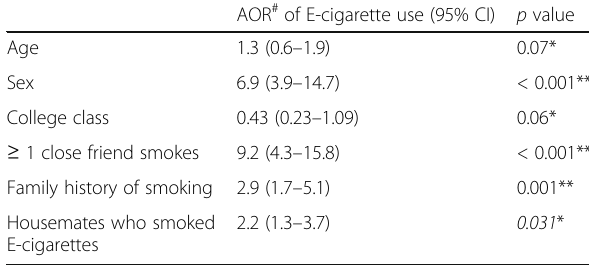
Table 3 Factors associated with using E-cigarettes